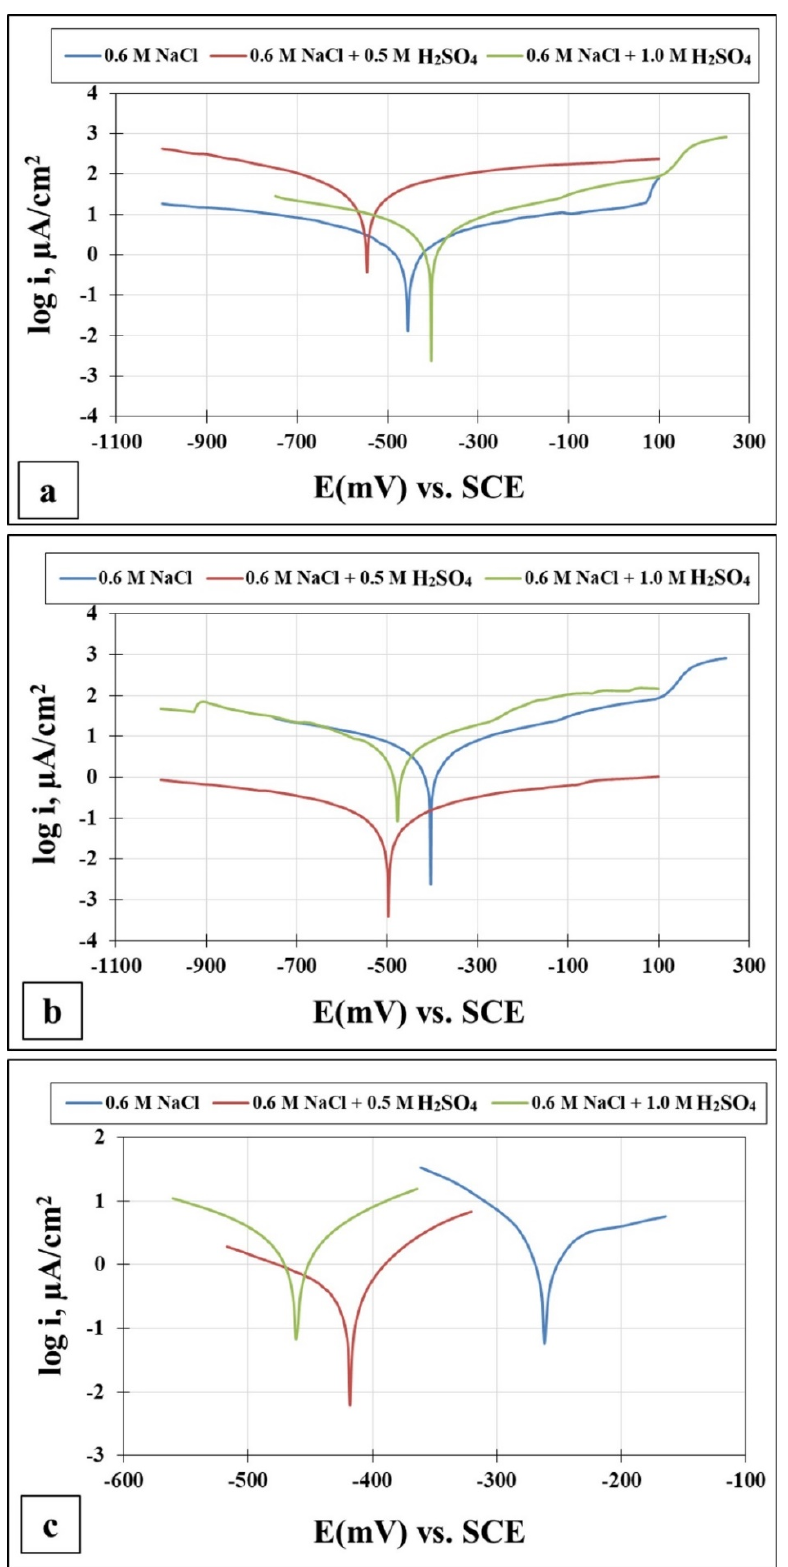
Figure 7. The corrosion behavior of the ( a ) cold-rolled HEA, ( b ) solution-treated HEA and ( c ) SS304 in different acidic medias.